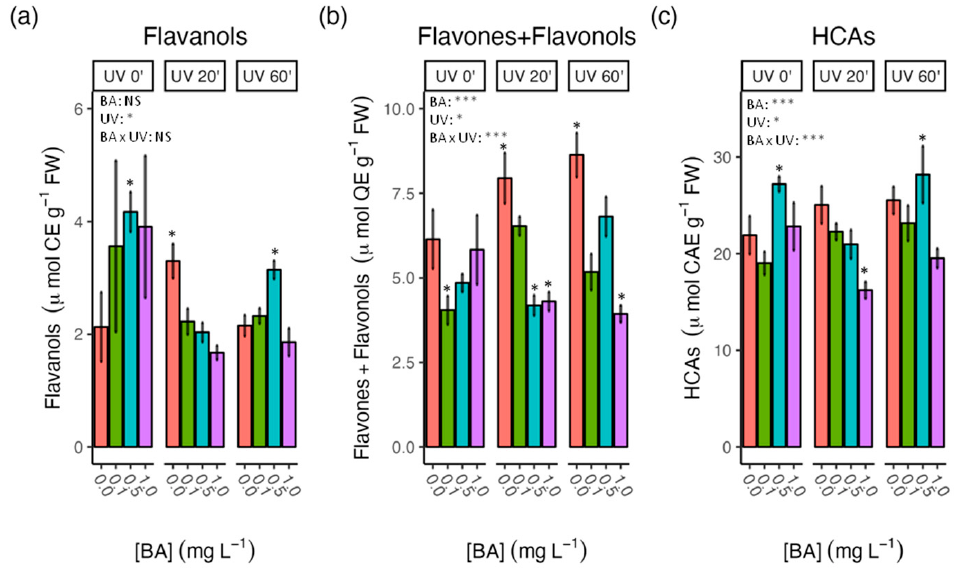
Figure 3. Effect of different concentrations of BA and UV-C treatments on the content of flavanols, flavones and flavonols, and hydroxycinnamic acids (HCAs) in 6-week-old carob shoots. ( a ) Total flavanols; ( b ) total flavones and flavonols; ( c ) HCAs. Each value represents the mean ± SE. Significant differences from the untreated controls by Tukey’s HSD test at p ≤ 0.05 are indicated with asterisks over the bars. p -values of the two-way ANOVA for the effects of BA dose (BA), UV-C treatment (UV) and their interaction (BA × UV) are indicated by asterisks: *, p ≤ 0.05; ***, p ≤ 0.001; NS, not significant.